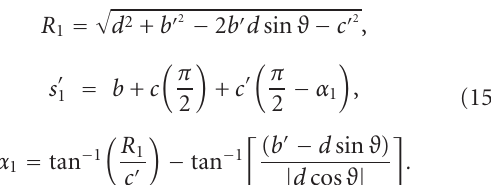
Figure 4: Relevant to the rounded cylinder